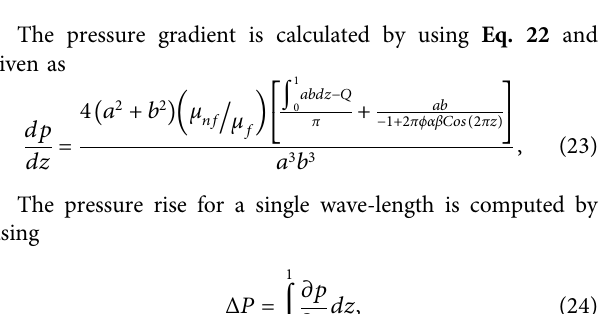
FIGURE 11 | (A) dp plot against axial coordinate for aspectratio . (B) dp dz volumefractionof nanofluid . (D) dp plot against axial coordinate for flowrate dz